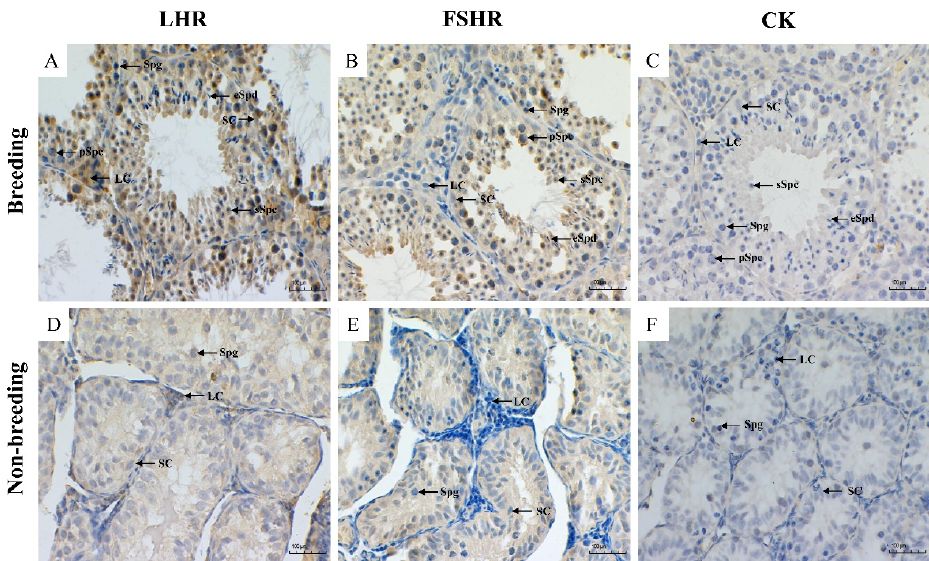
Figure 2. Immunohistochemistry results of luteinizing hormone receptor (LHR) and follicle stimulating hormone receptor (FSHR) in the testes of plateau zokor ( Eospalax baileyi ) during the breeding and non-breeding season. ( A , D ): the immune localization of LHR in the testes of plateau zokor, ( B , E ): the immune localization of FSHR in the testes of plateau zokor, and ( C , F ): the control using phosphate buffered saline (PBS) instead of the first antibody. Scale bars, 100 µm. SC, Sertoli cell; LC, Leydig cell; Spg, spermatogonia; pSpc, primary spermatocyte; sSpc, secondary spermatocyte; eSpd, elongated spermatid.